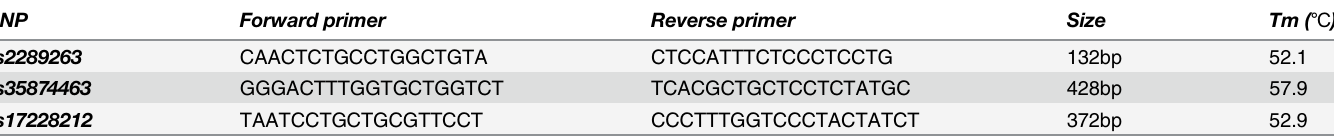
Table 5. PCR primers used for SNP statistical